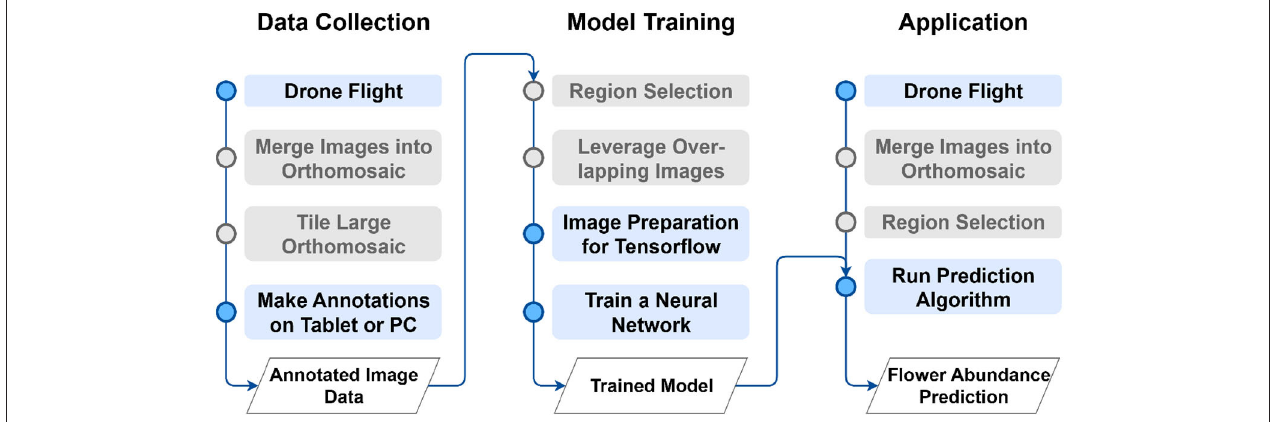
FIGURE 1 | Overview of the proposed method. Gray-colored steps might not be necessary for some use cases. For a comprehensive explanation of the main phases data collection (Section 2.2), model training (Section 2.3) and application (Section 2.4) please refer to the corresponding section.